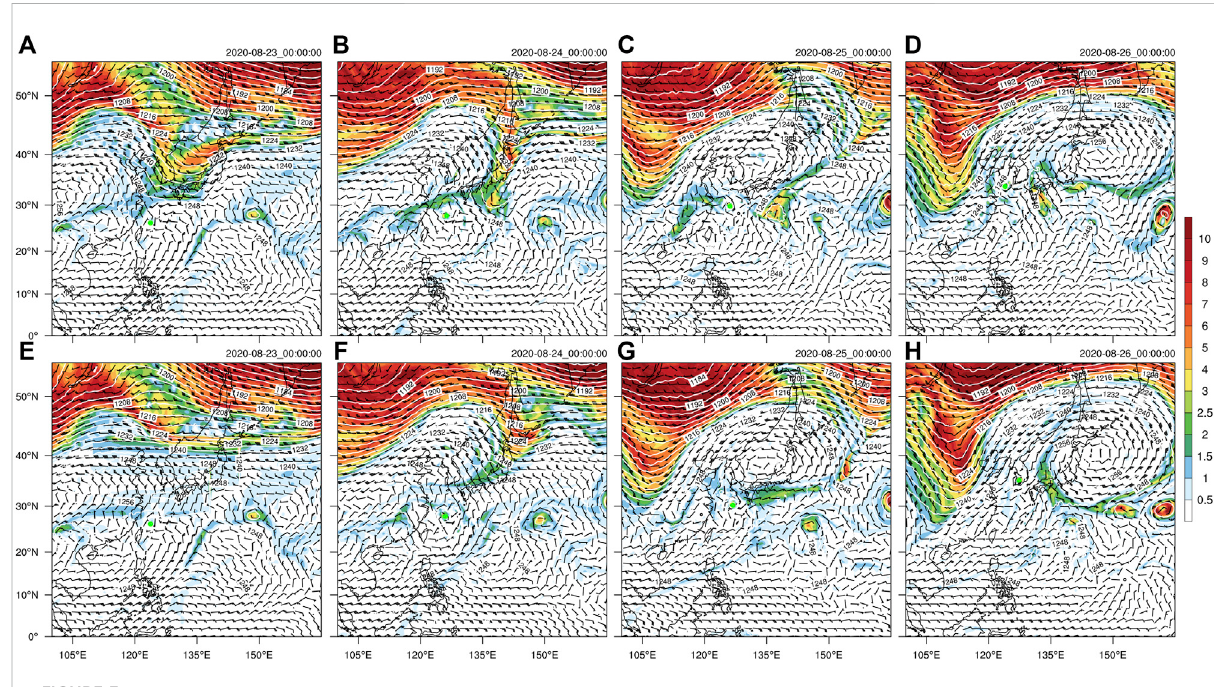
FIGURE 3 SimulatedPV (shaded, PVU), wind vectors, and geopotential height (contour,m) at200 hPa. The upper panels are for CTRL experimentand the lower panels are for No-trough experiment,